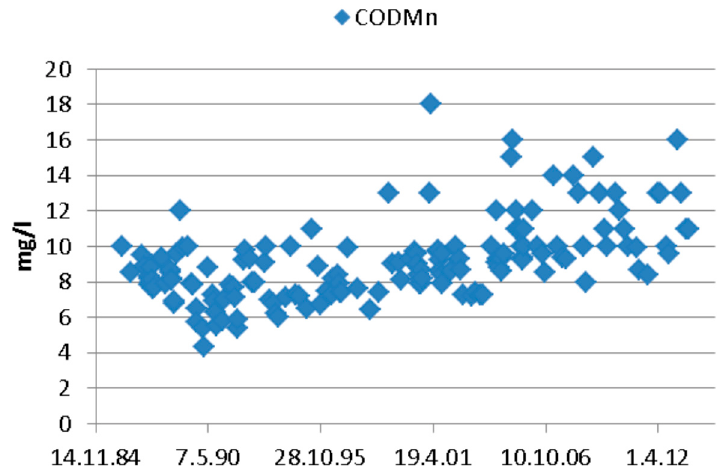
Figure 6. The development of organic matter content of Lake Haukkajärvi measured as COD Mn (monitoring data from the database of the Finnish Environmental Institute) [18].